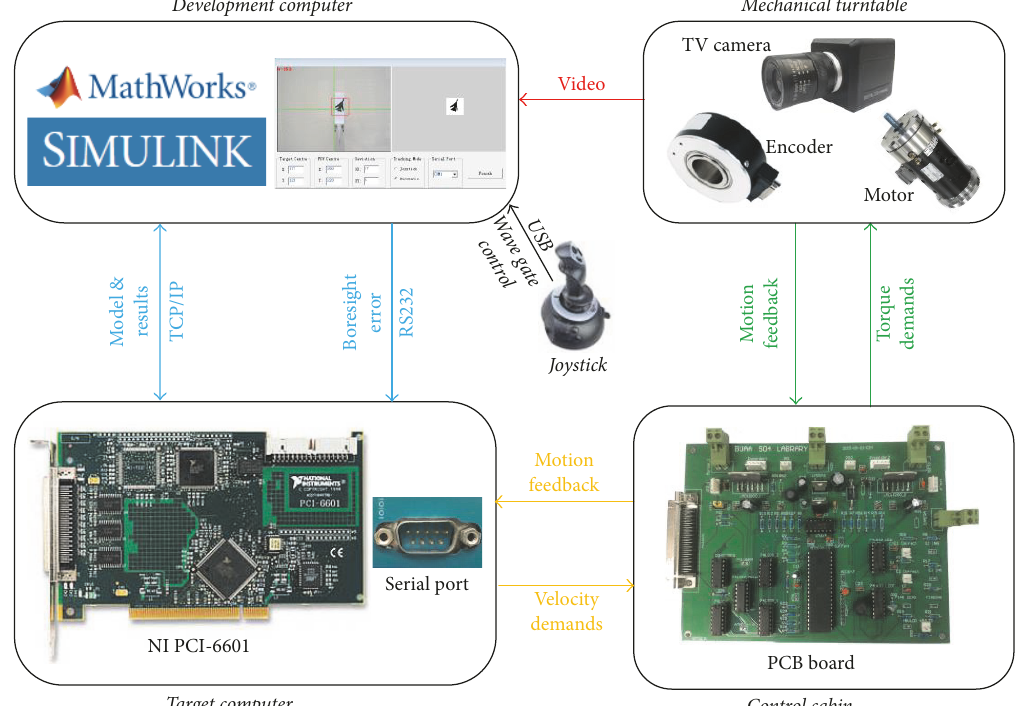
Figure 21: Signal transmission block diagram.